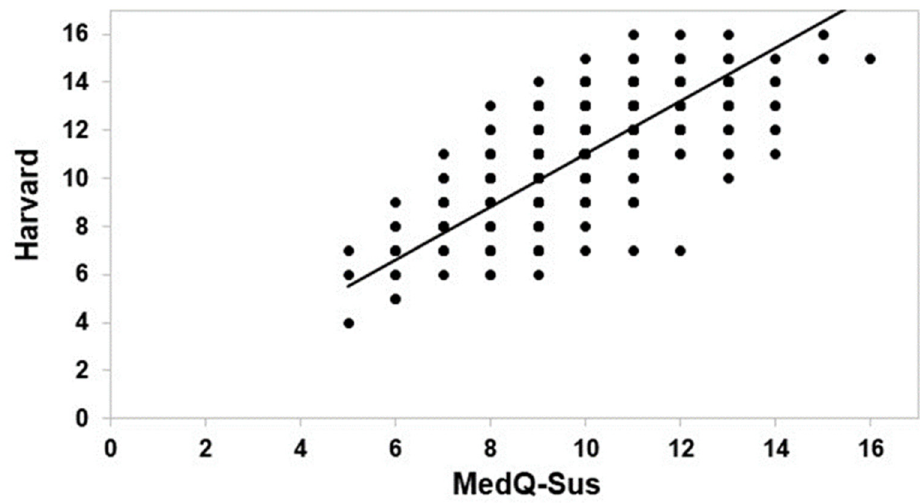
Figure 1. Spearman non-parametric correlation test between total score of Harvard and MedQ-Sus questionnaires.